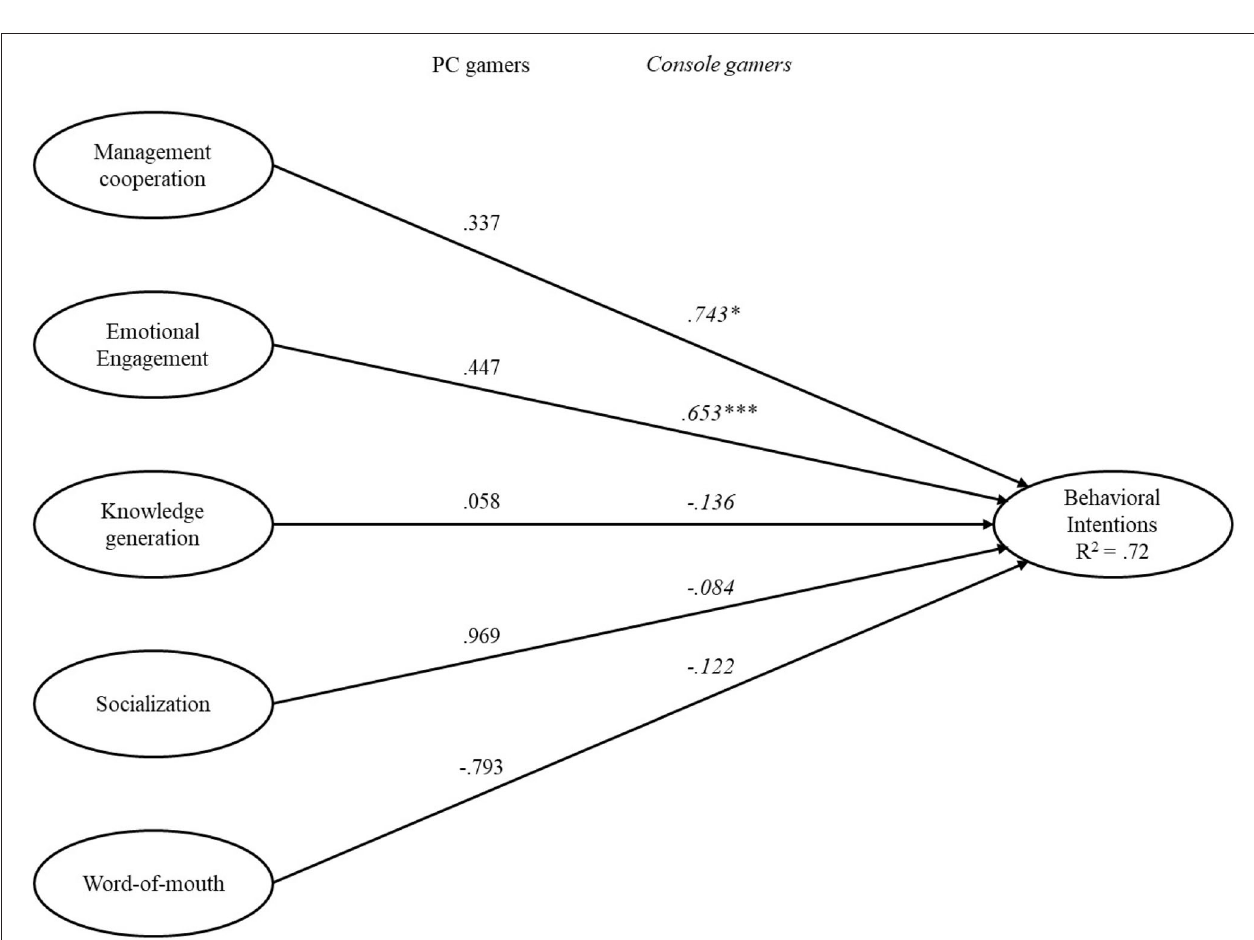
FIGURE 1 | Relationship between fan engagement and behavioral intentions. Note. Values in italics are for console gamers. Values not italicized are for PC gamers. *** p < 0.001, * p < 0.05.